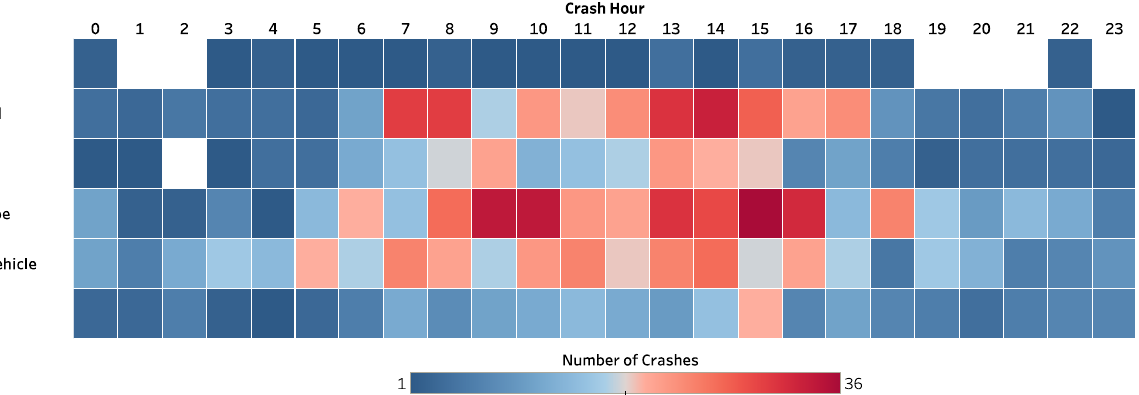
Figure 6. HAZMAT road transportation collision type proportions by crash severity.